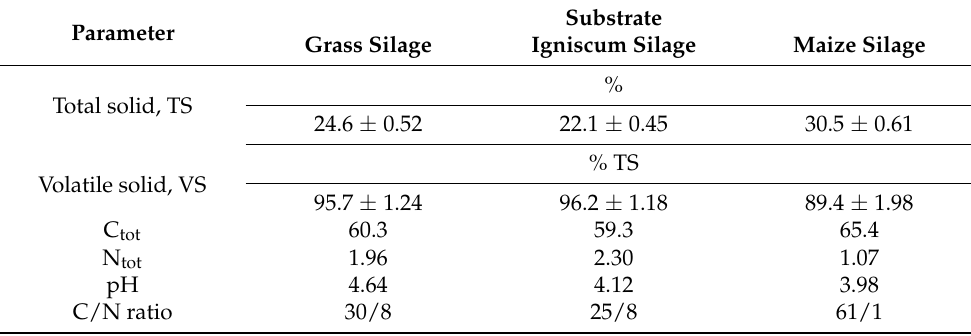
Table 1. Chemical and physical properties of the substrates used in this study. Substrate Parameter Grass Silage Igniscum Silage Maize Silage % Total solid, TS 24.6 ± 0.52 22.1 ± 0.45 30.5 ± 0.61 % TS Volatile solid, VS 95.7 ± 1.24 96.2 ± 1.18 89.4 ±